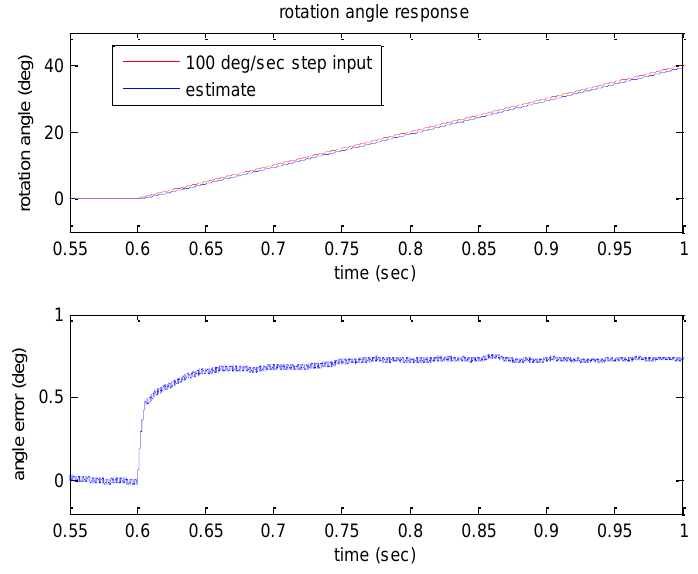
Figure 6. Time response of rotation angle estimate to the 100 deg/s step